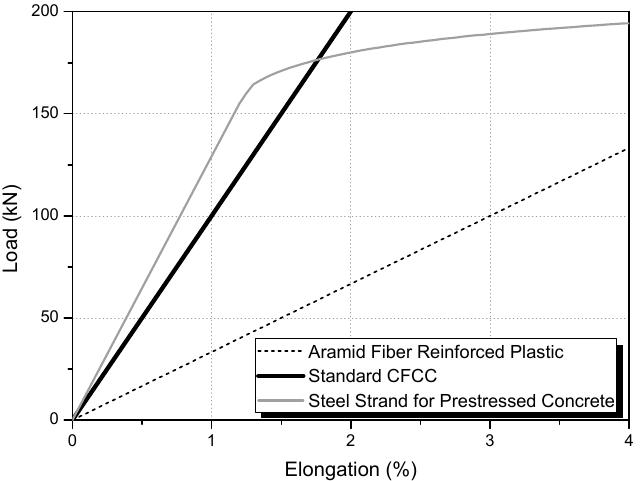
Figure 2. Load–elongation relations of standard carbon fiber composite cable (CFCC) (Tokyo Rope, [24] 2013). Reprinted with permission from reference [24]. Copyright 2013, Tokyo Rope.